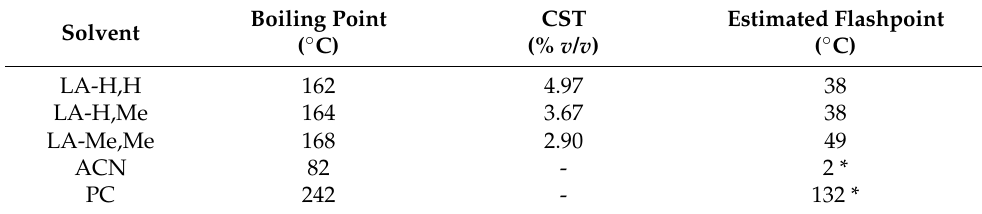
Table 1. DOLOs and commercial EDLC solvents flashpoints.